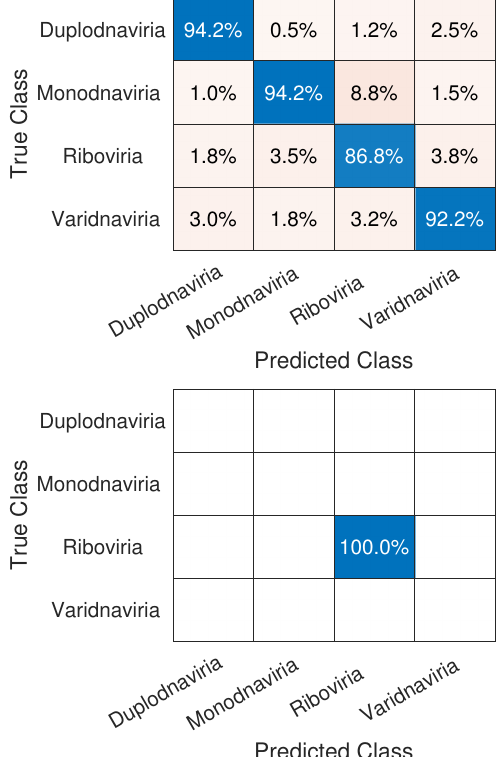
Figure 5. Confusion matrices for Experiment1, which show results for the classification of the viruses in their respective realms ( top ) and SARS-CoV-2 in the Riboviria realm ( bottom ). As in Exp1, to avoid overfitting, since we have families such as Reoviridae , with more than 1000 samples, and Picornaviridae and Caliviridae , with more than 400, we randomly chose 100 samples of each to form Dataset4, which was used for training and validation in Exp2, totaling 1600 samples. In Figure 6, we have the confusion matrices for validation of the network using Dataset4, and, in Figure 7, the test was completed with Dataset1.